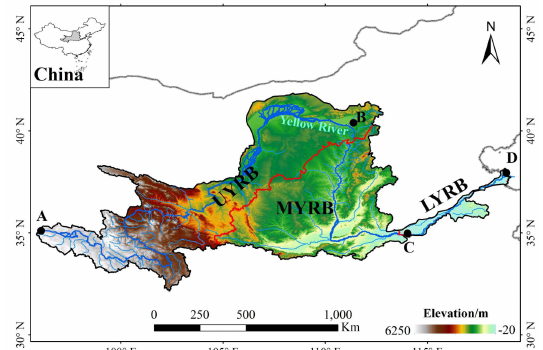
Figure 1. Yellow River Basin, the study area. The red line delineates three areas (UYRB: upper reaches of the Yellow River Basin; MYRB: middle reaches of the Yellow River Basin; LYRB: lower reaches of the Yellow River Basin). A continuous blue bolded curve shows the Yellow River, which passes from the Tibetan Plateau through the Alashan Plateau, the Ordos Plateau, and the Loess Plateau before finally joining the Bohai Sea. Points A, B, C, and D are the key points of the Yellow River. B is the dividing point between upstream and midstream, and C is the dividing point between midstream and downstream.